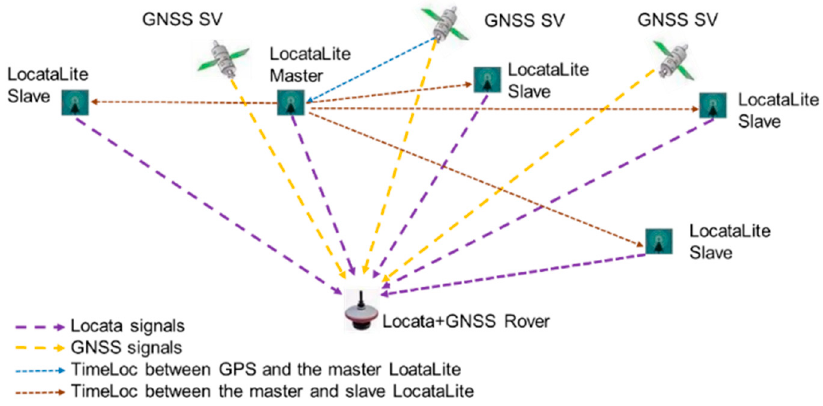
Figure 1. The Locata technology positioning concept.